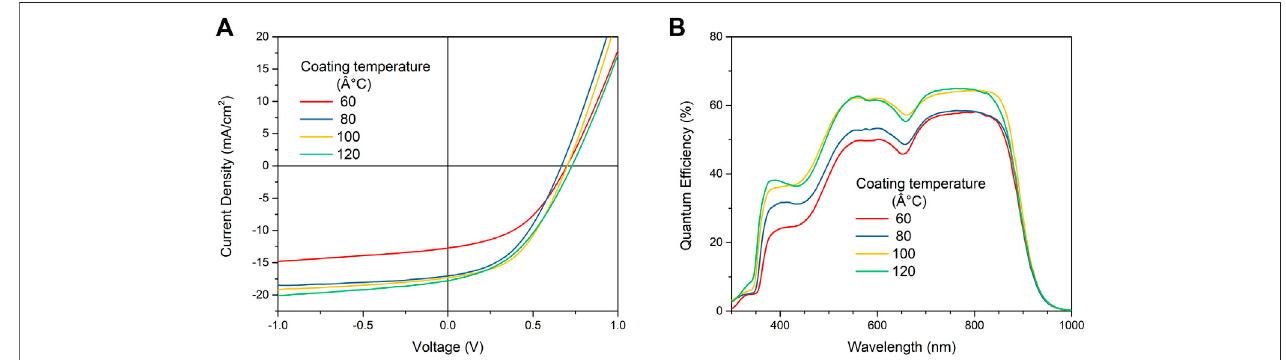
FIGURE 2 | (A) J-V curve comparison of devices coated at different temperatures. Measurements done under simulated solar light AM1.5G and 1000 W/m 2 and (B) External Quantum Ef fi ciency (QE) of PM6:Y6 solar cells coated at different temperatures.